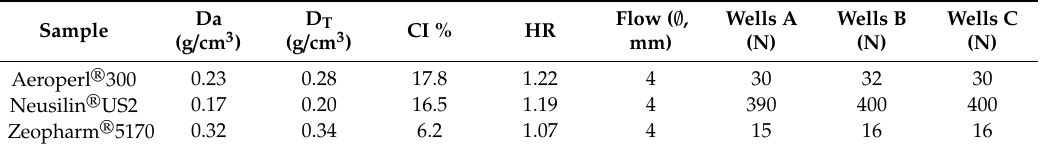
Table 1. Apparent (D A ) and tapped (D T ) Density, Carr Index % (CI), Hausner Ratio (HR), flowability (as flow through an orifice), and compactability (determined by Wells test A, B and C) of Aeroperl ® 300, Neusilin ® US2, Zeoparm ®